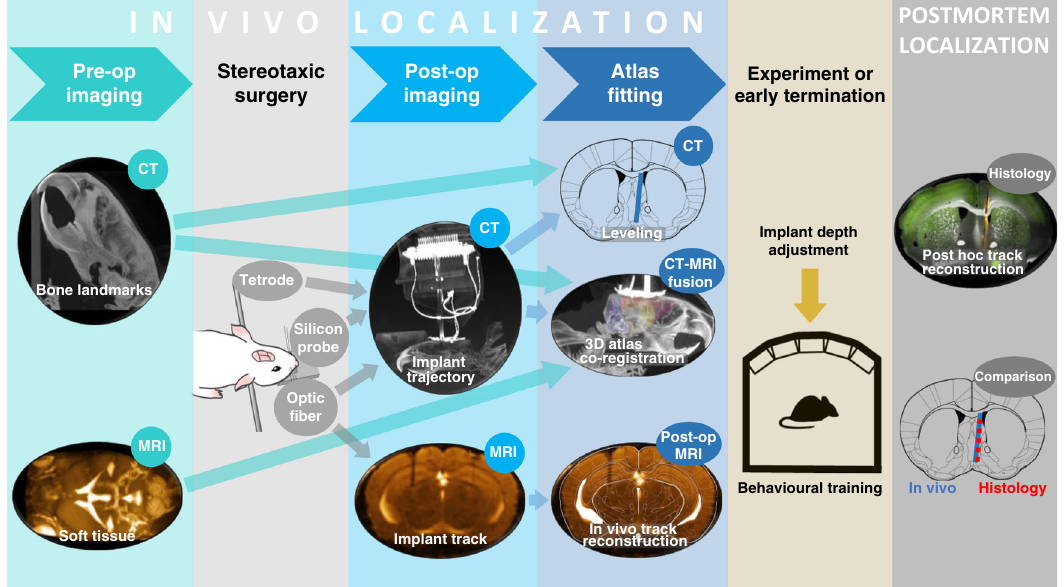
Fig. 1 In vivo localization work fl ow. A few days before the surgery, preoperative CT and MRI scanning is performed, providing anatomical information about bone landmarks and brain structures, respectively. After 4 – 12 days of recovery from the stereotaxic surgery, postoperative CT images are taken, and the position of the implant is determined in a co-registered atlas coordinate system. In case of nonmetal implants, a single postoperative MRI scan provides an alternative option, which allows in vivo track reconstruction analogous to histological track reconstruction. Based on the results, the trajectory of the implant is extrapolated, the depth of the implant may be adjusted before the experiment, or in the case of mistargeting, early termination is considered. After the experiments, the accuracy of the in vivo localization is veri fi ed by post hoc